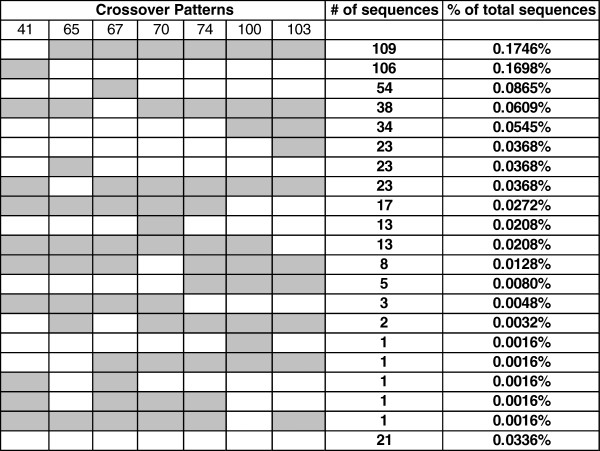
Crossover patterns of recombinant sequences from Run3 MID11 obtained using low recombination PCR conditions. The second row shows the drug resistance codon positions. The 1st to the 7th columns show the nucleotides at each of the 7 sites with WT marked in white and mutant marked in gray. Detectable crossover events are shown as color changes (from white to gray or from gray to white). The last row represents recombinants that have one or more nucleotides in the drug resistance codons missing from sequencing.